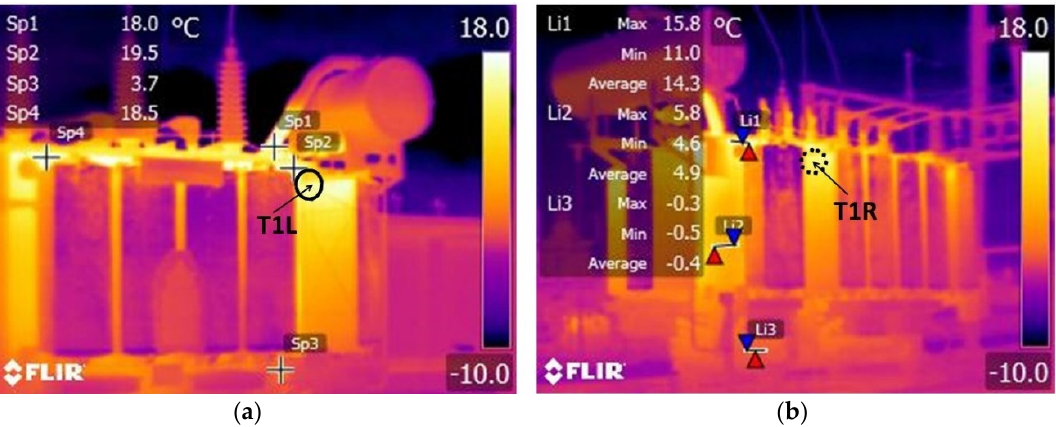
Figure 9. Thermograms of the IR radiation from the transformer’s surface recorded from both sides of the conservator taken in the wintertime, with quantitative information on the temperatures at the selected measurement points. The higher IR emissions area is the hot spot T1L (( a )—the surface area delimited by a black circle) and the hot spot T1R (( b )—the surface area delimited by a black circle with a dashed line).